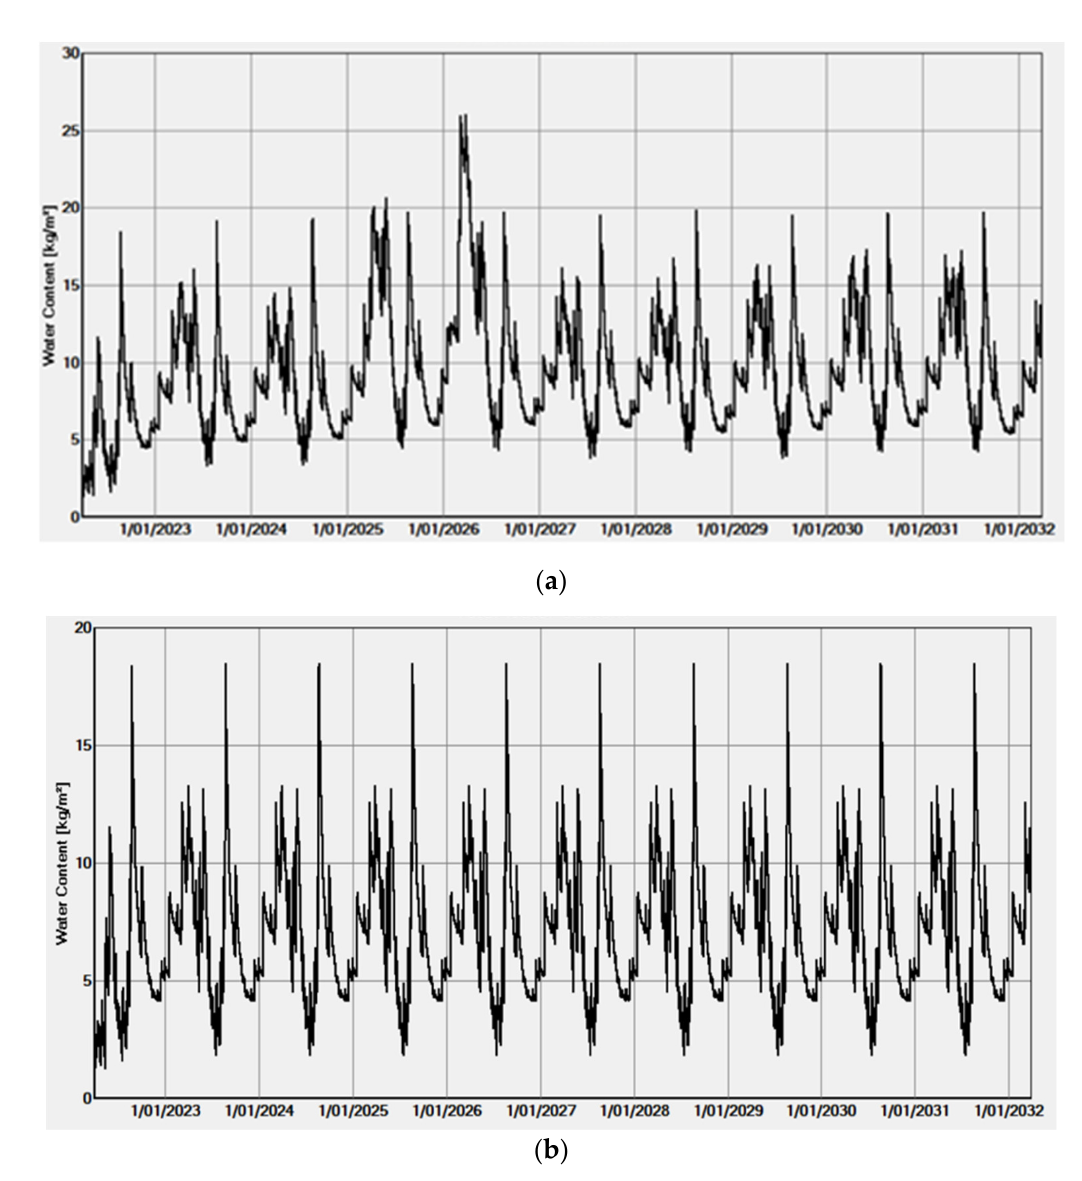
Figure 16. ( a ): Single point 10-year fluctuation of moisture content for the wall assembly in west orientation for pliable membrane D and E; ( b ): multipoint 10-year fluctuation of moisture content for the wall assembly in west orientation for pliable membrane D and E.